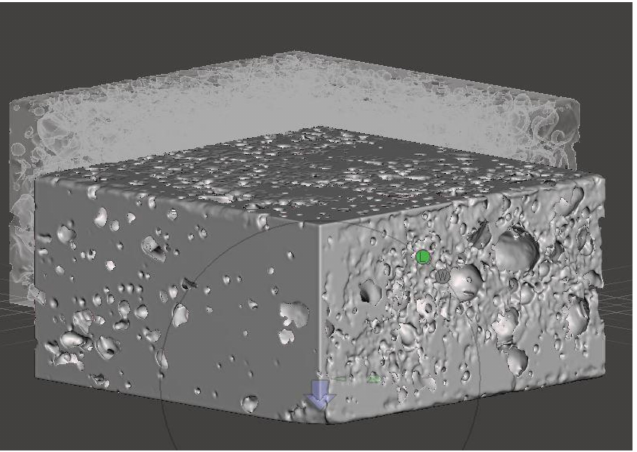
Figure 9. Meshmixer align tool distinguishing the solid and pore structure presence of the “.stl” file of the A1 × 11 3D